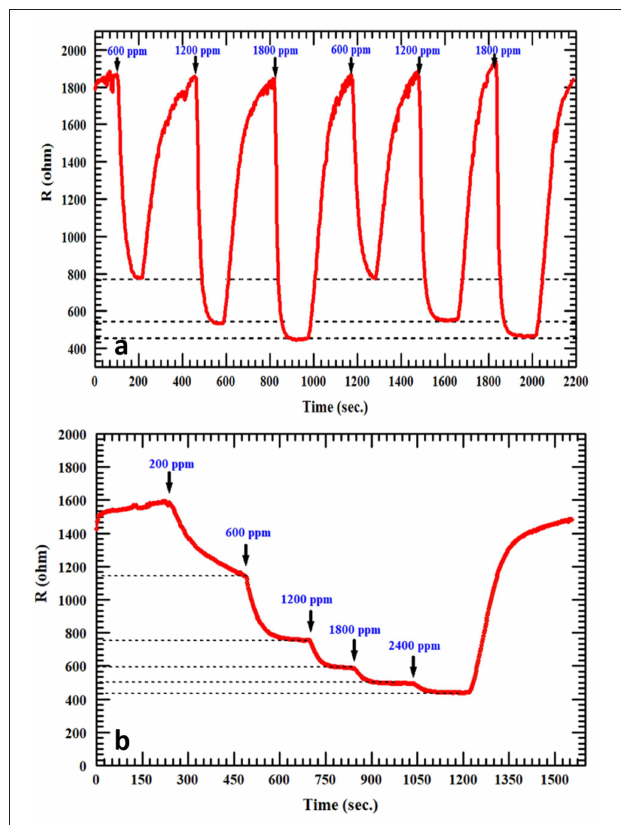
FIGURE 7 | (a) Repeatability test at 600, 1,200, and 1,800 ppm of H 2 for AgNPs/SnO 2 . (b) Staircase behavior of AgNPs/SnO 2 sensor.